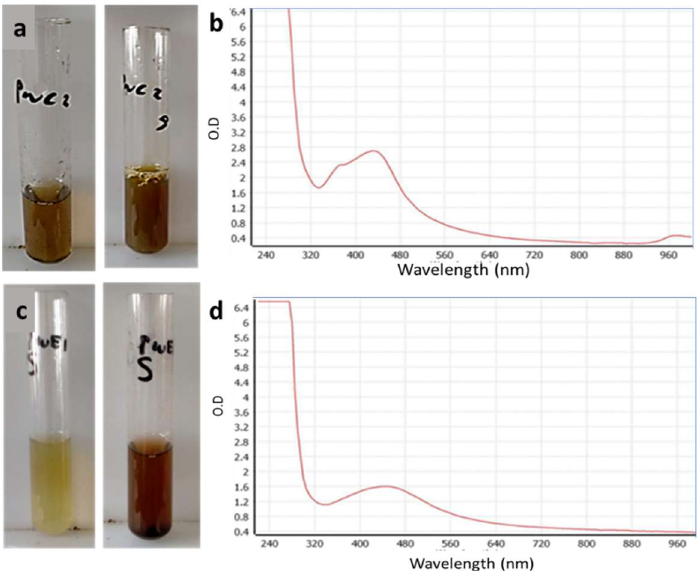
Figure 2. Color change due to formation of AgNPs by CE ( a ) and EE ( c ) and UV–vis spectra showing a clear plasmon band for AgNPs synthesized by PWC ( b ) and PWE ( d ).